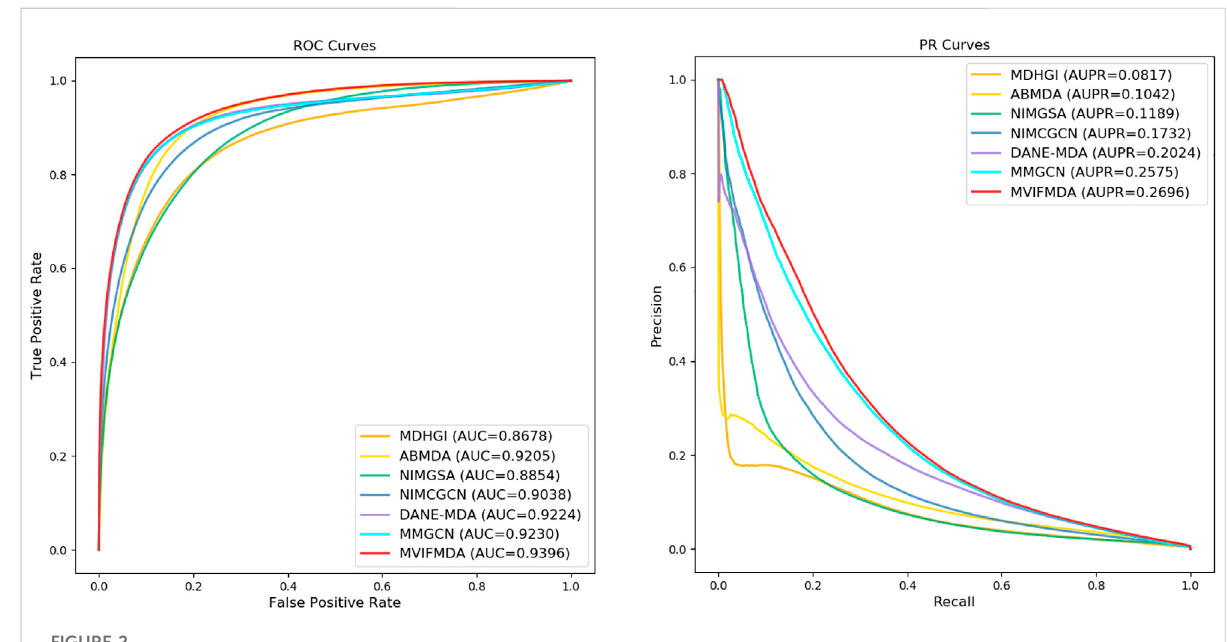
FIGURE 2 ROC curves and PR curves of MVIFMDA with all comparison